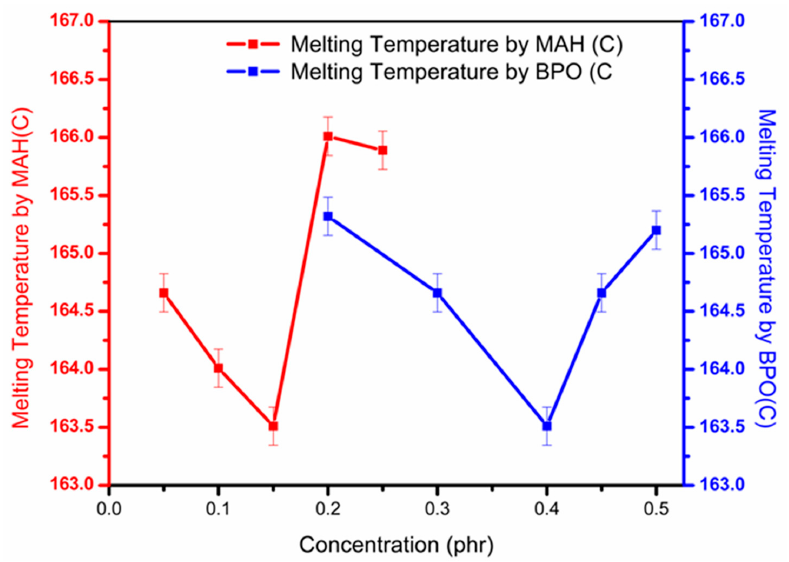
Figure 7. Effect on melting temperature (T m ) for grafted samples by varying MAH and BPO contents.